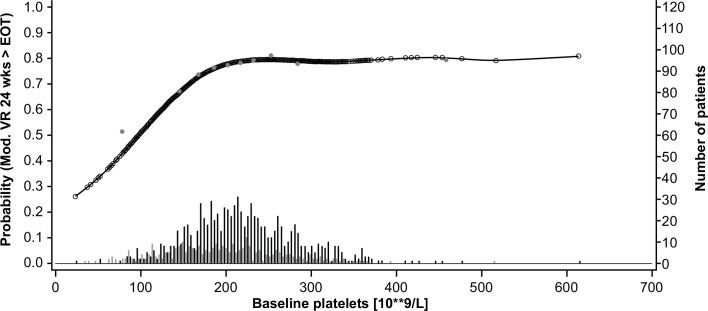
Relationship between platelet count and sustained virologic response (SVR).Short vertical lines indicate the number of patients with SVR (black lines) and no SVR (grey lines). Open circles represent probability of SVR according to the GAM analysis. Closed circles represent empirical probability for midpoints of deciles.